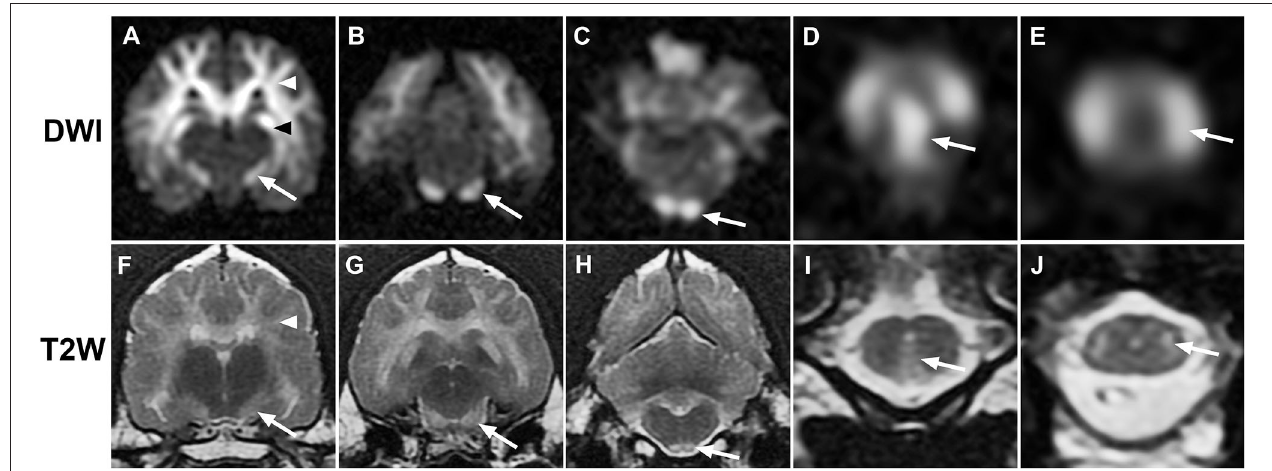
FIGURE 1 | Sequential transverse MR images from case 1. (A–E) , diffusion-weighted (DWI); (F–J) , T2-weighted (T2W): Diffuse bilaterally symmetrical hyperintensity involving white matter tracts is present on DWI and T2W images. Hyperintensity consistent with the descending corticospinal tract (white arrows) is present at the level of the internal capsule (A,F) , midbrain crus (B,G) , pyramidal tracts (C,H) , pyramidal decussation (D,I) , and lateral corticospinal tracts (E,J) . Additional white matter tracts are defined, including corona radiata [ (A,F) , white arrowheads] and hippocampal fornix [ (A) , black